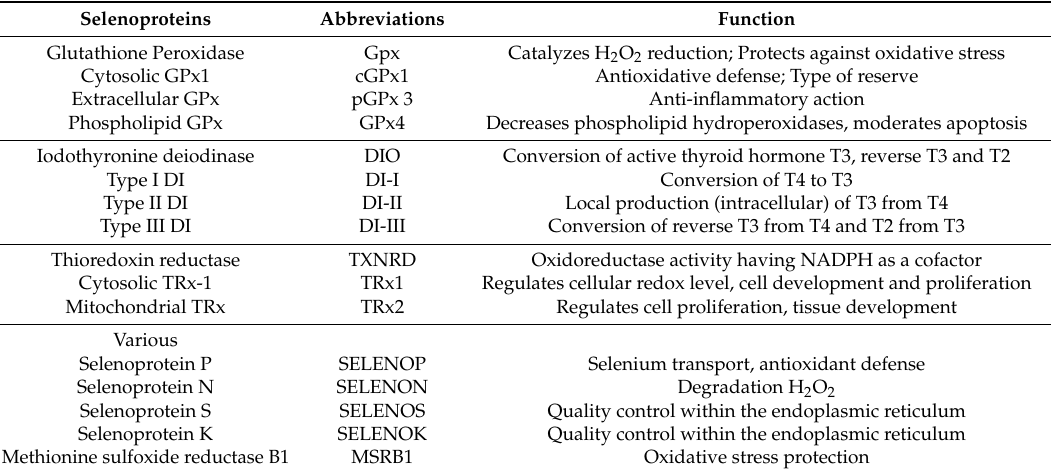
Table 1. Selenoproteins expressed in the thyroid and/or involved in the biosynthesis of thyroid hormone and protection of the thyroid gland (adapted from